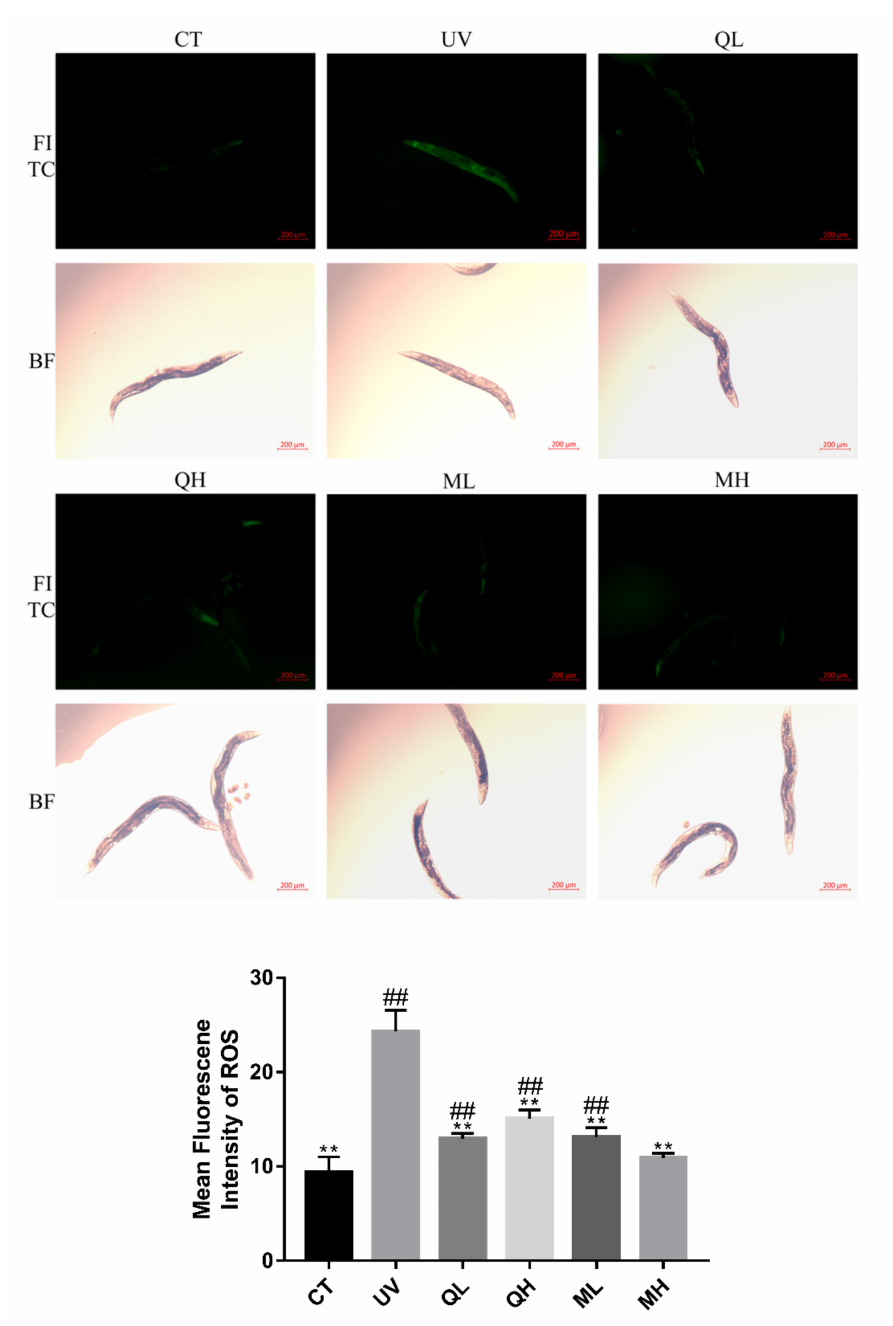
Figure 4. The MFI results of C.elegans stained by 2 (cid:48) ,7 (cid:48) -dichlorofluorescein show the ROS levels of every groups. These pictures were taken in a 50 × field of view (FITC and BF). The higher the ROS level, the brighter the green fluorescence. All data are mean ± SEM and were analyzed by two-tailed Student’s t -test, n = 7, * p < 0.05, ** p < 0.01 compared to UV group. # p < 0.05, ## p < 0.01 compared to MH